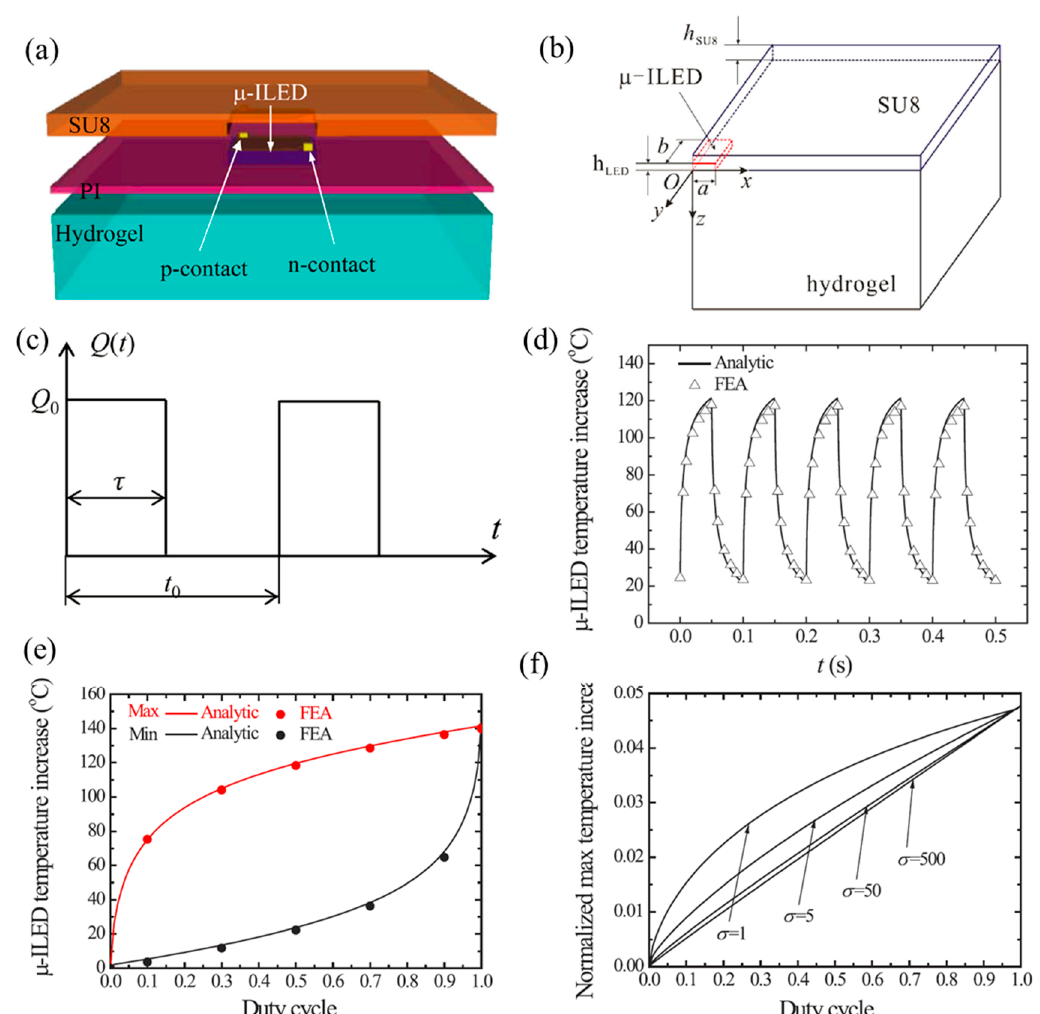
Figure 3. Schematic illustration of ( a ) the µ -ILED layout and ( b ) a quarter geometry of the analytic modeled µ -ILED system [57]. ( c ) The pulsed power Q ( t ) with Q 0 as the peak power [57]. ( d ) The µ -ILED temperature increase versus time [57] after saturation [57]. ( e ) The maximum and the minimum temperature increases versus duty cycle after saturation [57]. ( f ) The maximum normalized temperature increase of µ -ILED versus duty cycle with various values of σ [57].